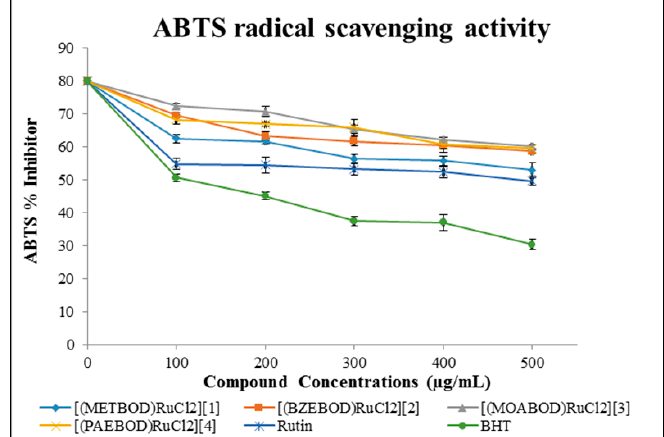
Figure 2. ABTS activities of heterocyclic Ru(III) complexes and standard